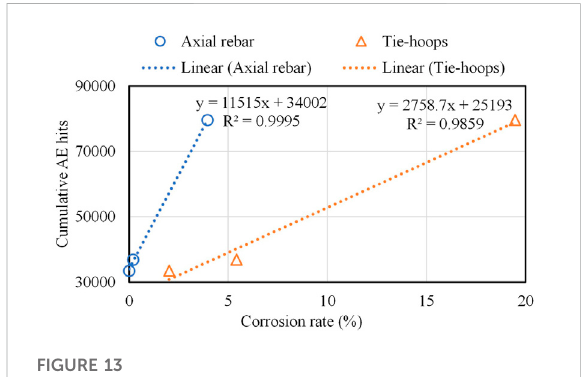
FIGURE 13 Relationship between the corrosion rate and cumulative AE hits during compression test in uncoated